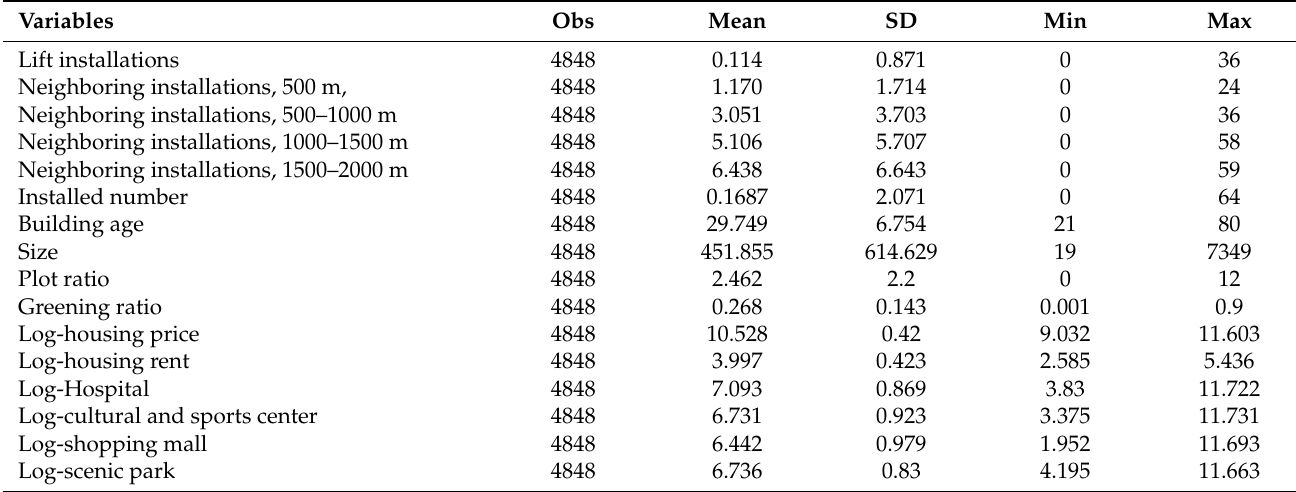
Table 1. Summary